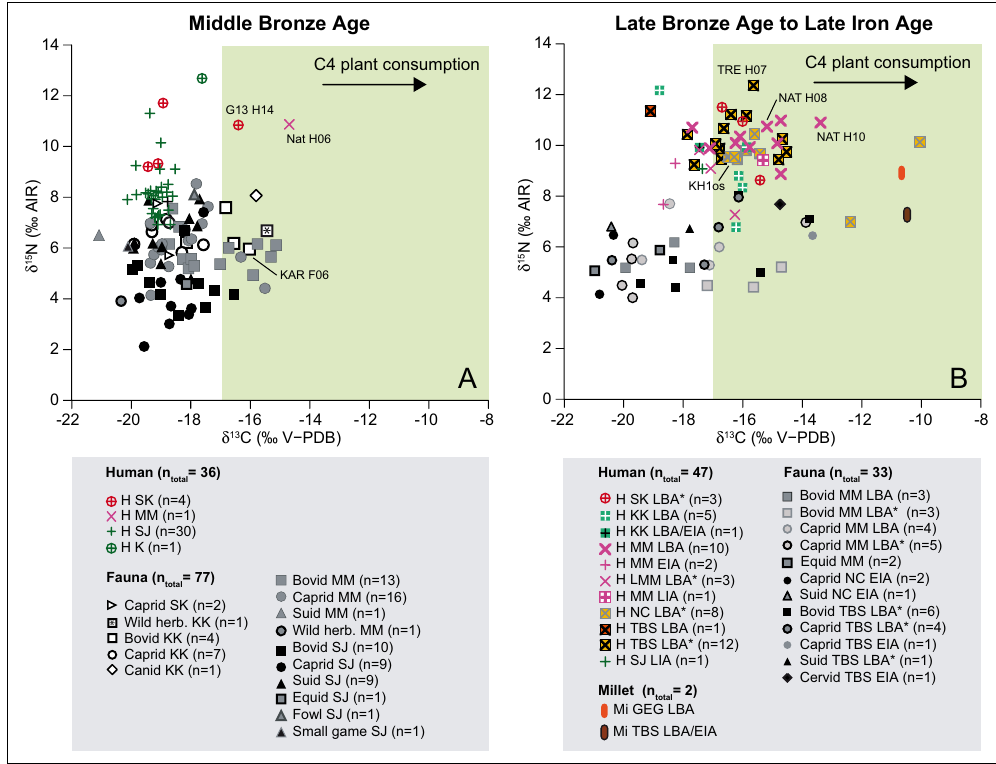
Figure 3. Animal and human stable carbon and nitrogen isotope ratios according to geographical area for Middle Bronze Age ( A ) and Late Bronze Age to late Iron Age ( B ). H: Human, Mi: millet; Geographical areas: SK: Samtskhe-Javakheti; MM: Mtskheta-Mtianeti; SK: Shida kartli; KK: Kevmo Kartli; K: Kakheti; TB: Tbilisi District; NC: North Caucasus, GEG: Gegharot; * : means that the chronological period overlaps the transition with the following period (For highlighted individuals see SI dataset S2; SI appendix tab.